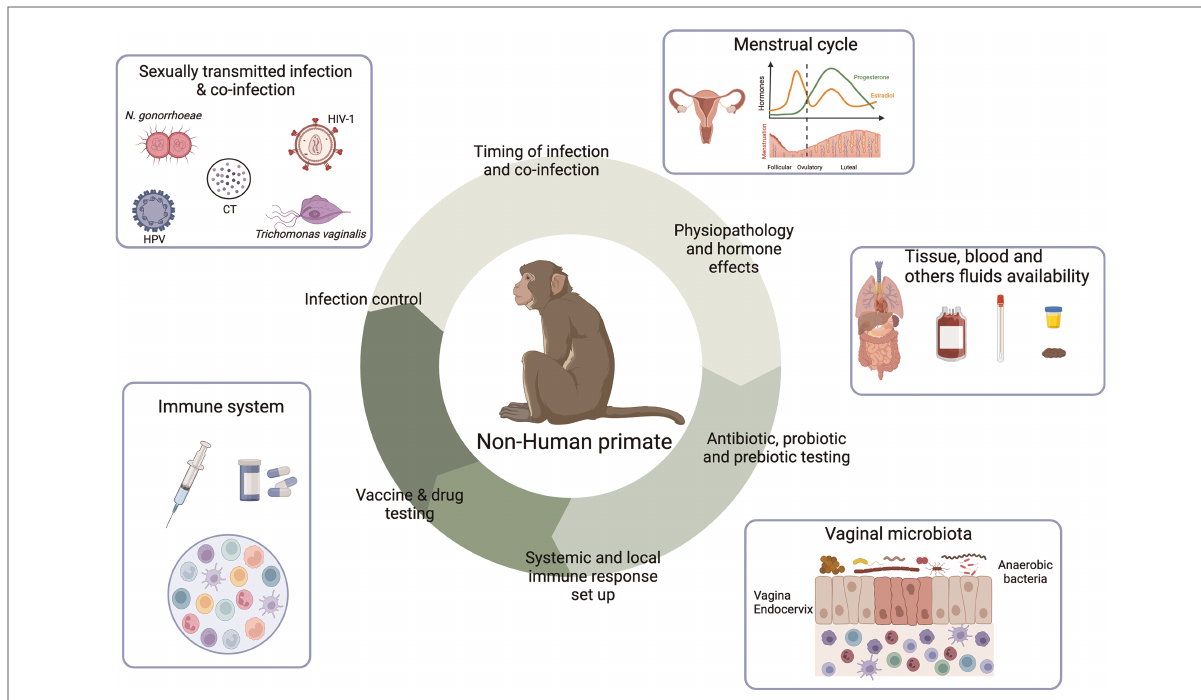
FIGURE 4 Contribution of the female NHP model in the understanding of the mechanisms involved in sexually transmitted infection acquisition and control. NHP and Human similarities include NHP susceptibility to several STI affecting Human, FRT anatomy, menstrual cycle, immune cells presence and vaginal microbiota composition. This model also allows the longitudinal collection of tissue samples, stool, blood or cervicovaginal fl uids. Therefore, NHP can be used to study various parameters involved in STI acquisition and control including time and route of infection, susceptibility to infection/ co-infection, physiopathology, hormone effects, in deep evaluation of the immune system, probiotic/prebiotic/vaccine/drug testing. Created with